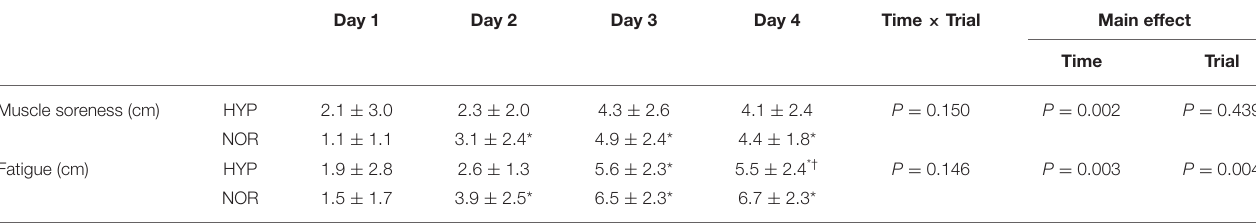
TABLE 4 | Changes in subjective feelings of fatigue and muscle